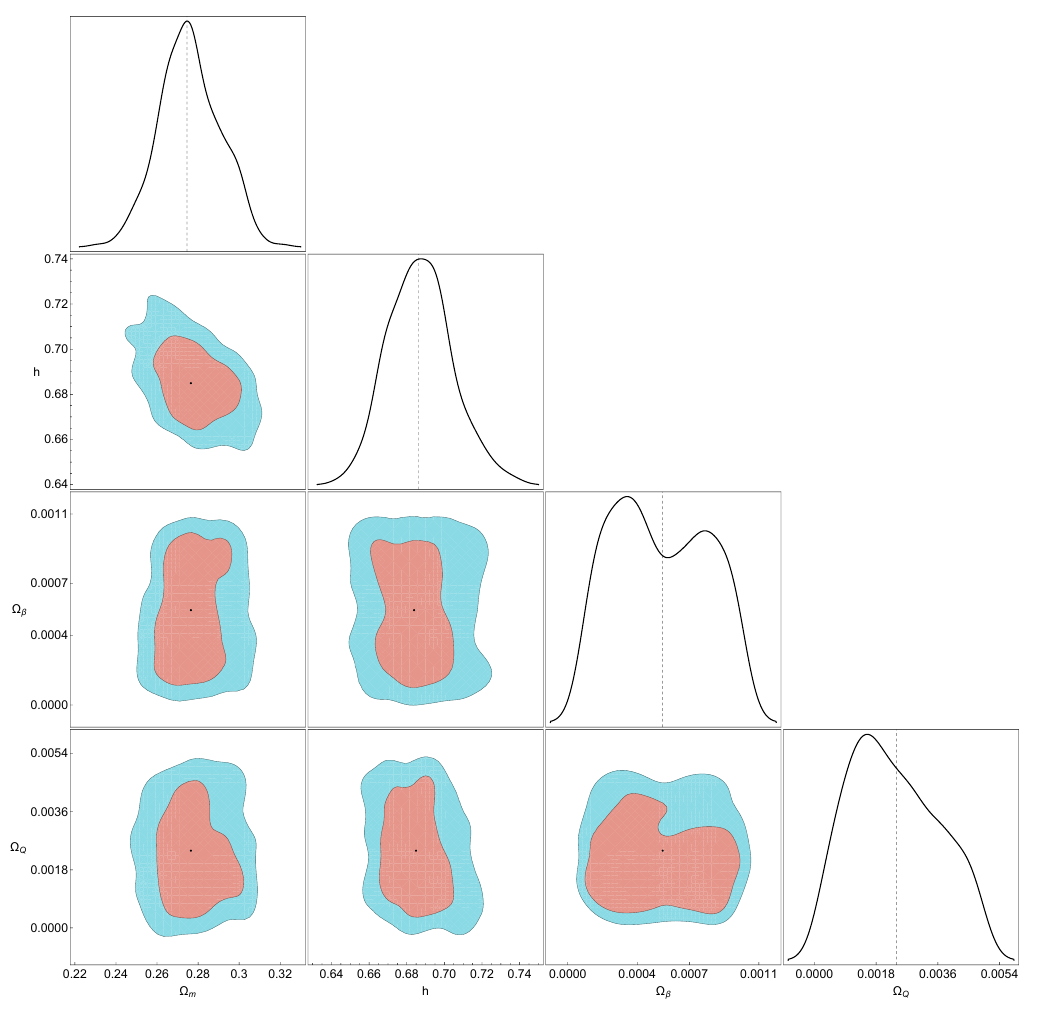
Figure 2 . The 68 . 3% and 95 . 4% confidence contours between parameters for the Hairy BH case and their 1D marginalized likelihood. The vertical dashed lines and black dots indicate the mean MCMC values at ( Ω m , h , Ω β , Ω Q ) = ( 0 . 2765 , 0 . 6849 , 5 . 4624 × 10 − 4 , 2 . 3937 × 10 − 3